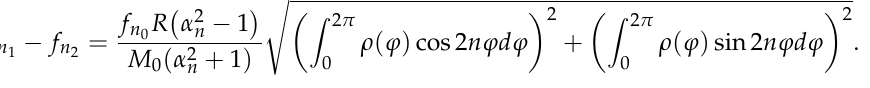
Figure 2. Schematic diagram of resonator vibration. AA, BB are the two eigenaxes. fn 1 , fn 2 are the natural frequency of the resonator.